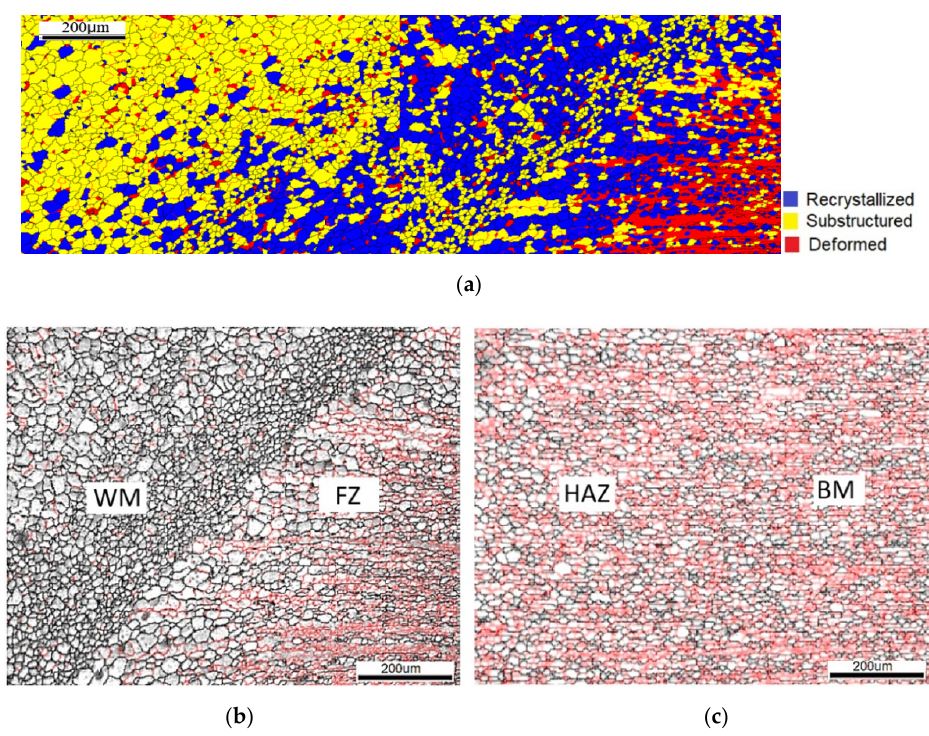
Figure 7. ( a ) Microstructure characteristic quantities of ( b ) joint and ( c ) grain morphologies. The corresponding temperature histories of thermal cycles at three locations of the joint hardness